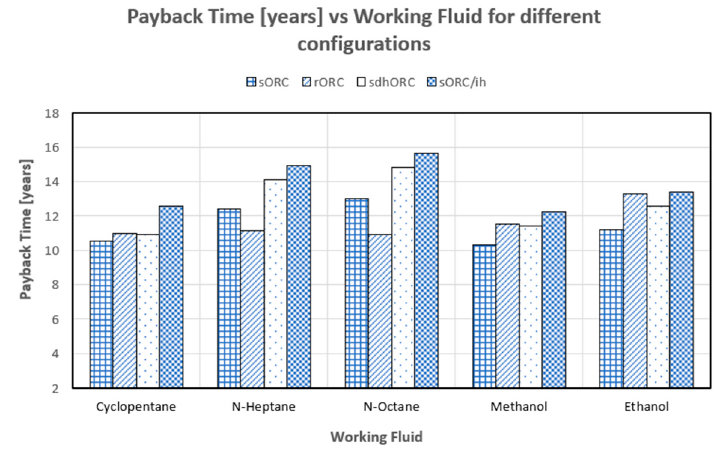
Figure 10. Payback time for ORC of different working fluids and cycle configurations.